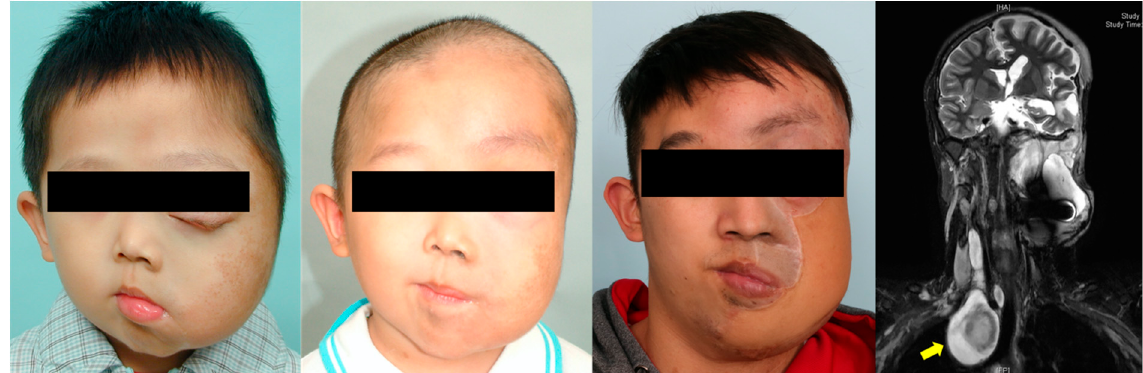
Figure 5. Clinical images of an 11-year-old boy with craniofacial plexiform neurofibromatosis who has been followed up with since the age of 2 and has been receiving orbital and zygomatic repositioning and reconstruction of the orbital roof and temporal bone. Owing to the disease progression, a radical excision was performed after preoperative embolization (branches of the left internal maxillary, lingual, and facial arteries) and total interruption of the left external carotid artery. The soft tissue defect was reconstructed with an anterior lateral thigh flap. Magnetic resonance imaging showed involvement of the left intraorbital, parasellar, parapharyngeal, and posterior pharyngeal regions and adjacent disorganized brain tissues and dural ectasia; craniotomy was performed for skull base and orbital tumor removal. Additional procedures included serial tumor excisions, lip repair, and canthoplasty. Magnetic resonance imaging indicated a mediastinal mass (yellow arrow) with neck swelling, and shortness of breath had developed in recent years. An additional neurofibroma compressing the cervical spine (C2 and C3 level) was also identified.